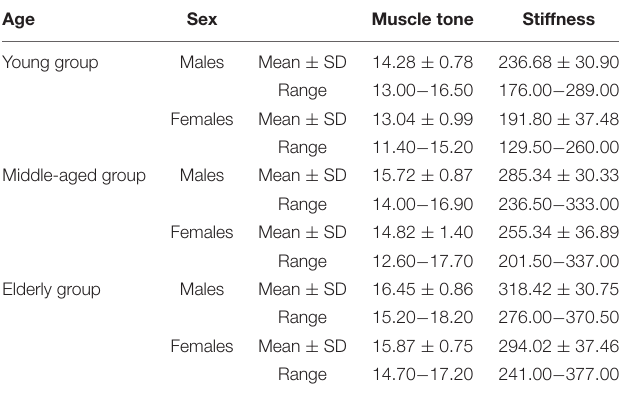
TABLE 2 | Properties of the lumbar erector spinae.